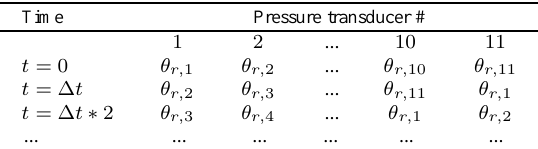
Table 1 Location of rotating coordinate system ( θ r ( t o )) with